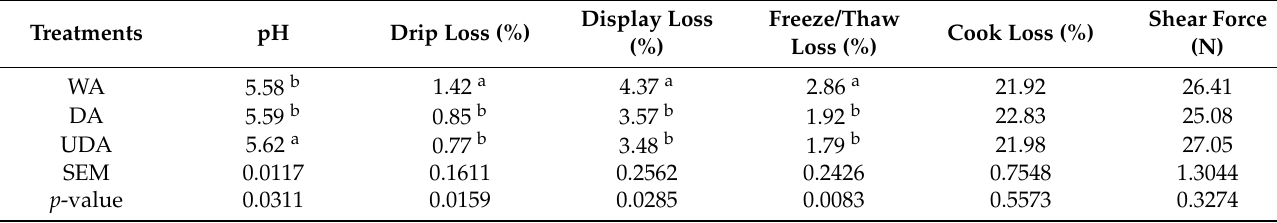
Table 2. Effect of different aging treatments on pH, water-holding capacity measurements, and shear force of pork loins ( M . Longissimus lumborum ) aged for 21